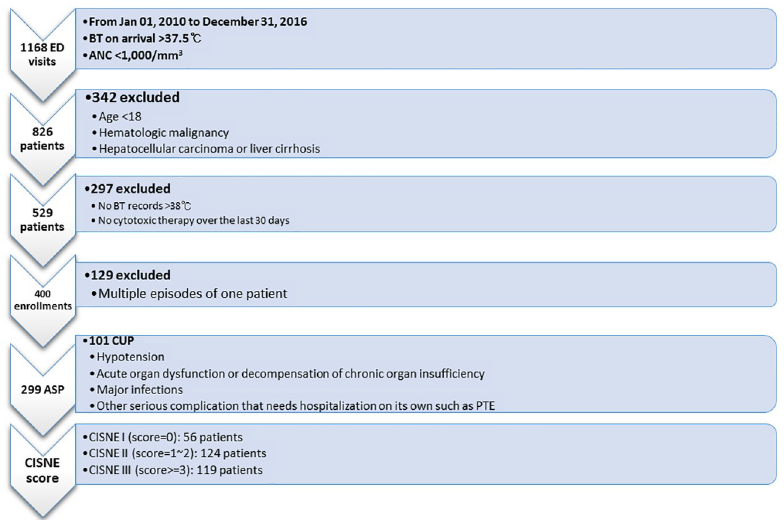
Fig 1. Study scheme. Two key conditions screened 1,168 patients who visited the emergency department from January 01, 2010 to December 31, 2016: a body temperature on arrival greater than 37.5˚C and an absolute neutrophil count smaller than 1000/mm 3 . The study finally enrolled 400 patients for analysis after excluding those who met any of exclusion criteria as illustrated. BT, body temperature; ANC, absolute neutrophil count; PTE, pulmonary thromboembolism; ASP, apparently stable patients; CUP, clinically unstable